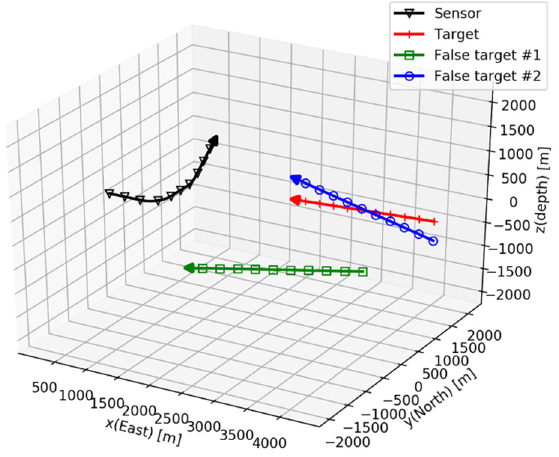
Figure 6. Target and two false targets.